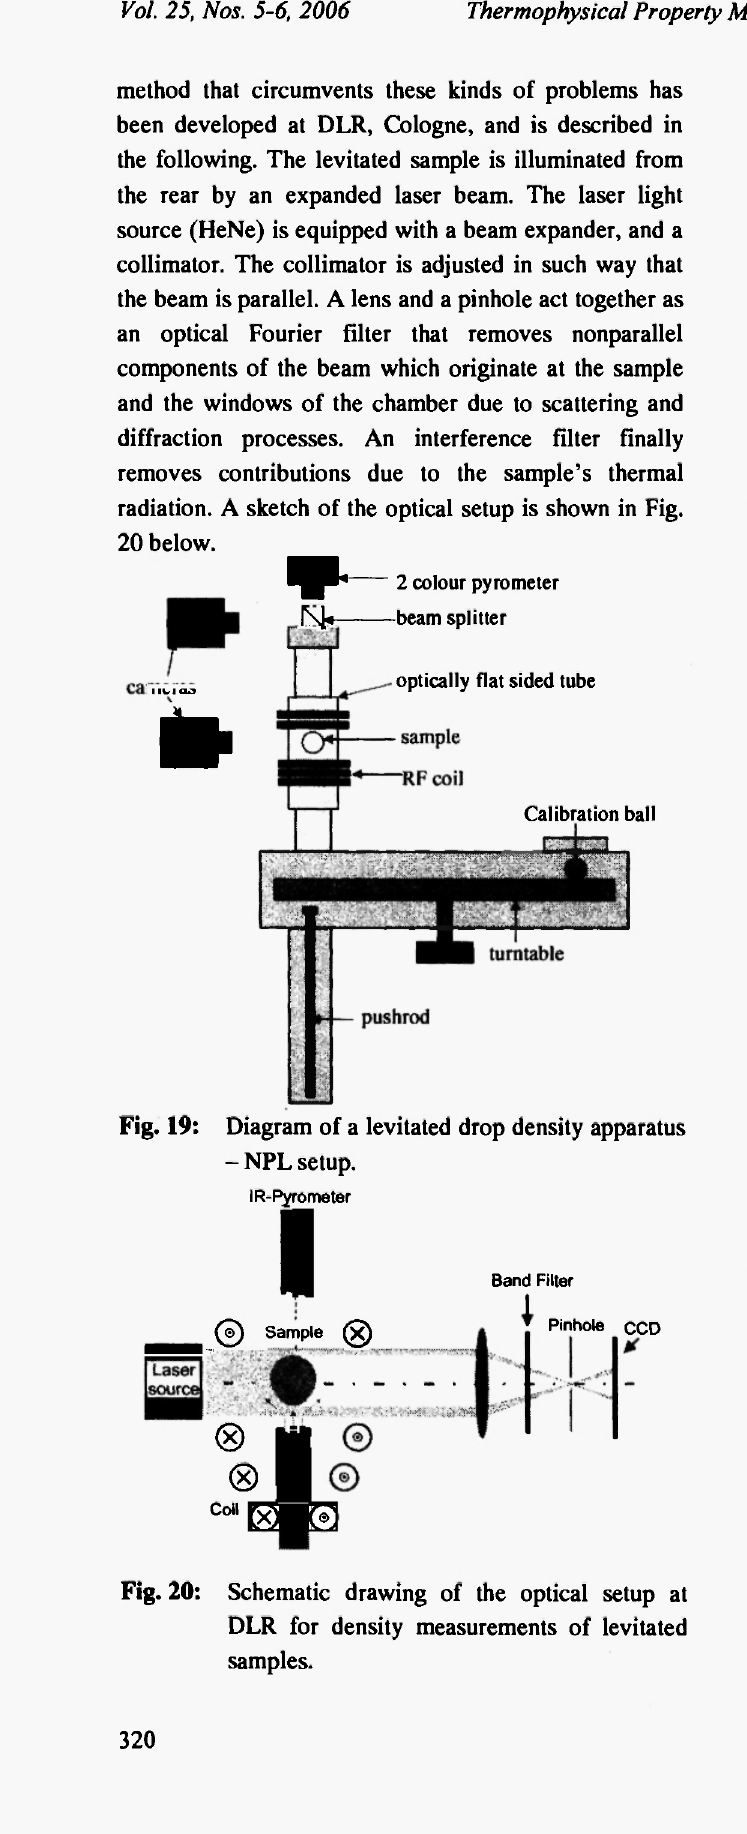
Fig. 20: Schematic drawing of the optical setup at DLR for density measurements of levitated